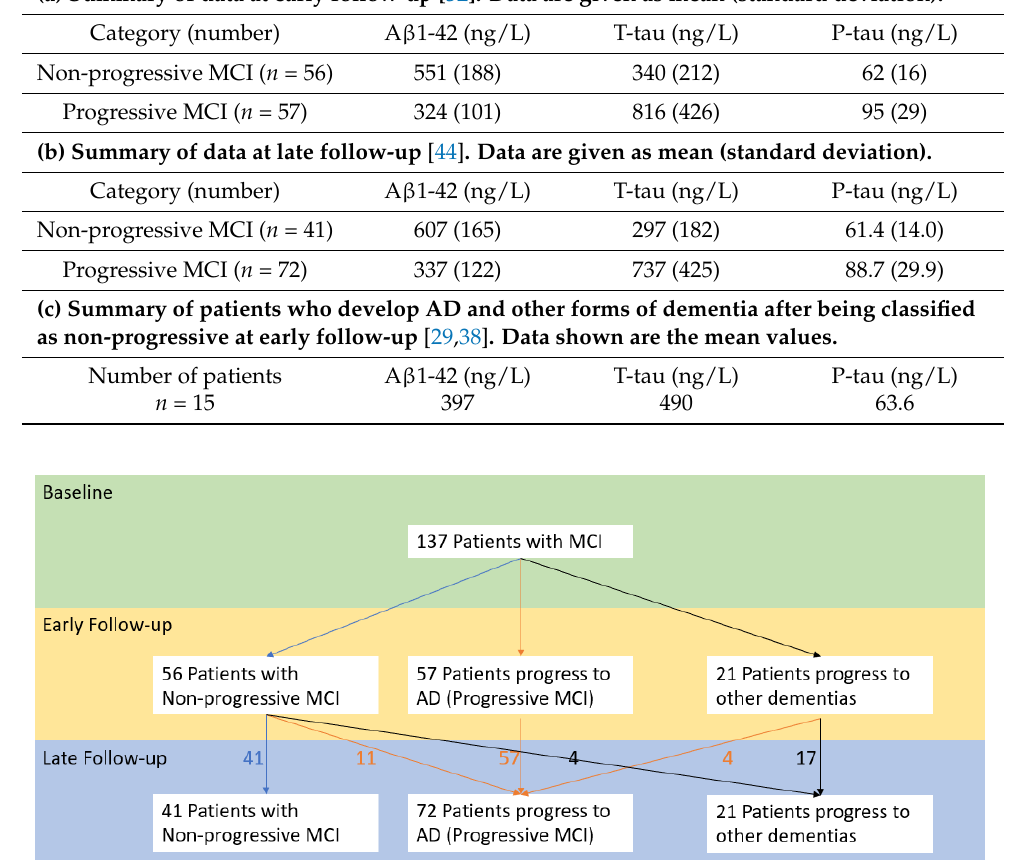
Figure 13. Illustrating the diagnostic trajectories for the 137 patients included in the studies